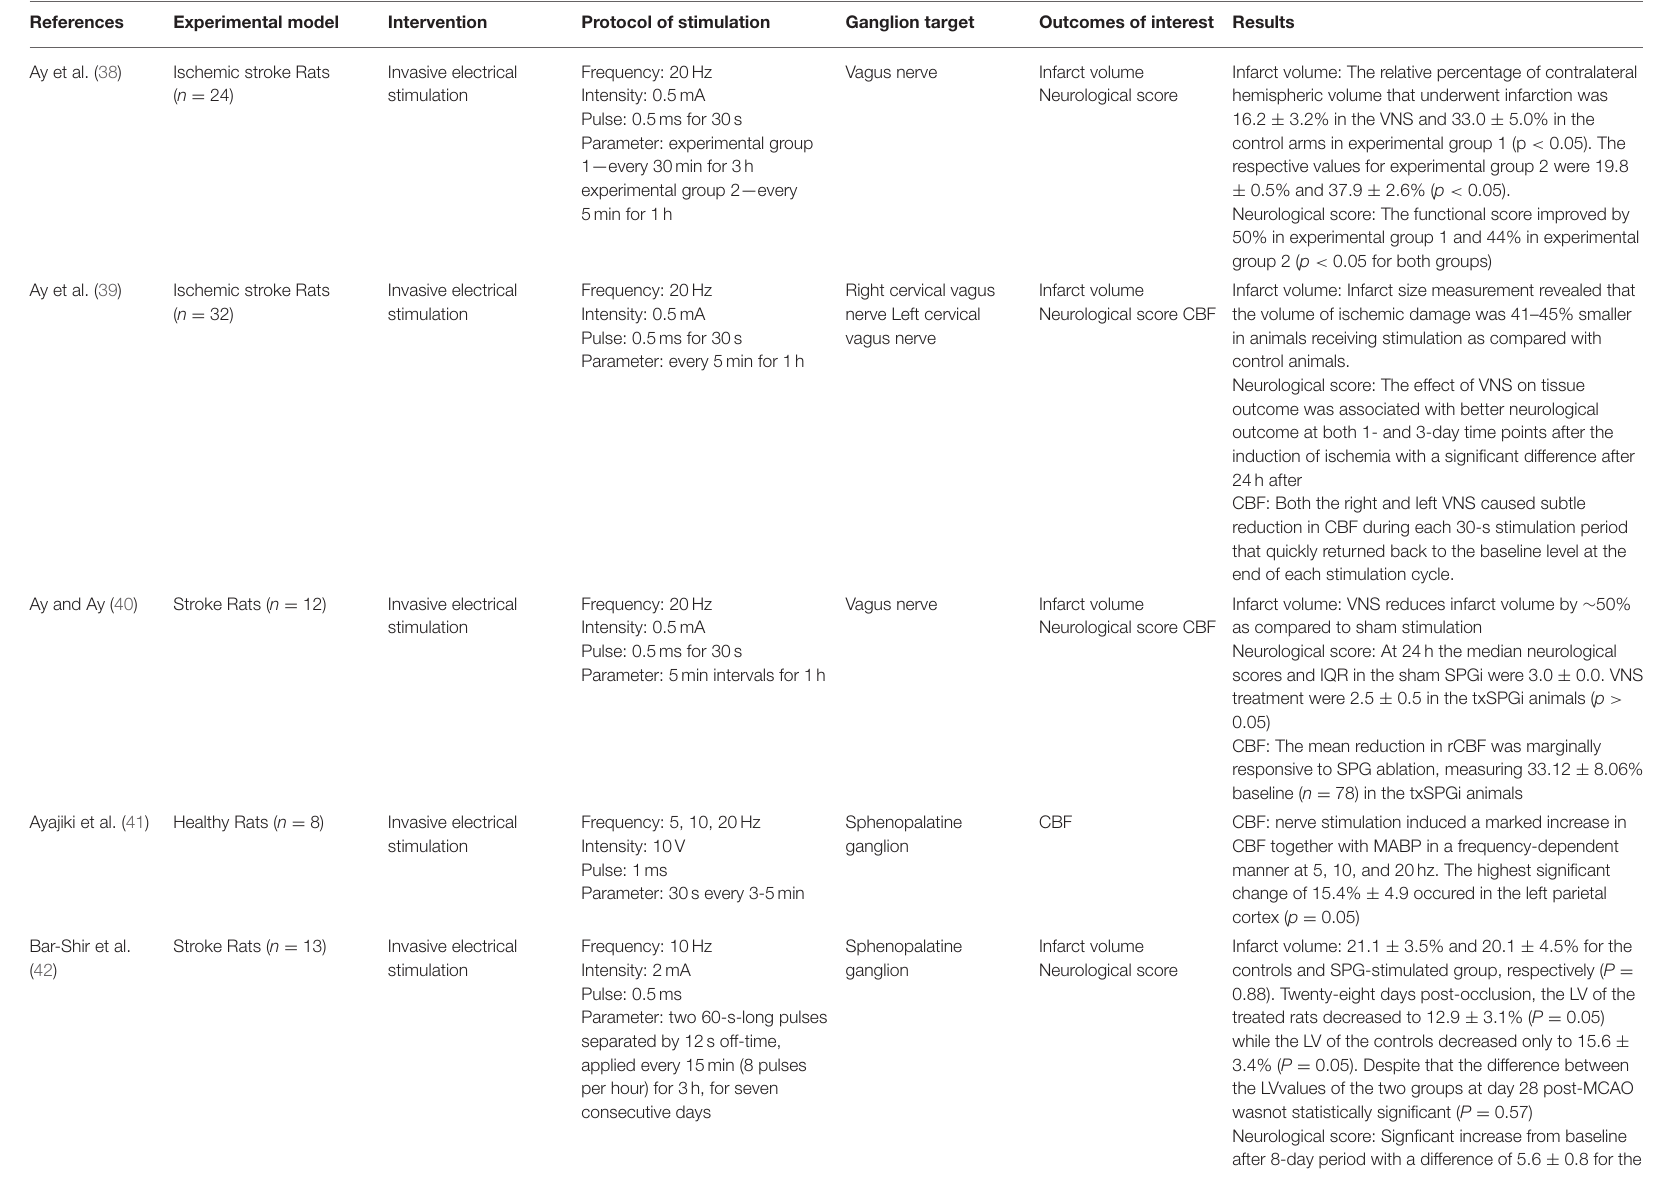
TABLE 3 | Characteristics of invasive animal